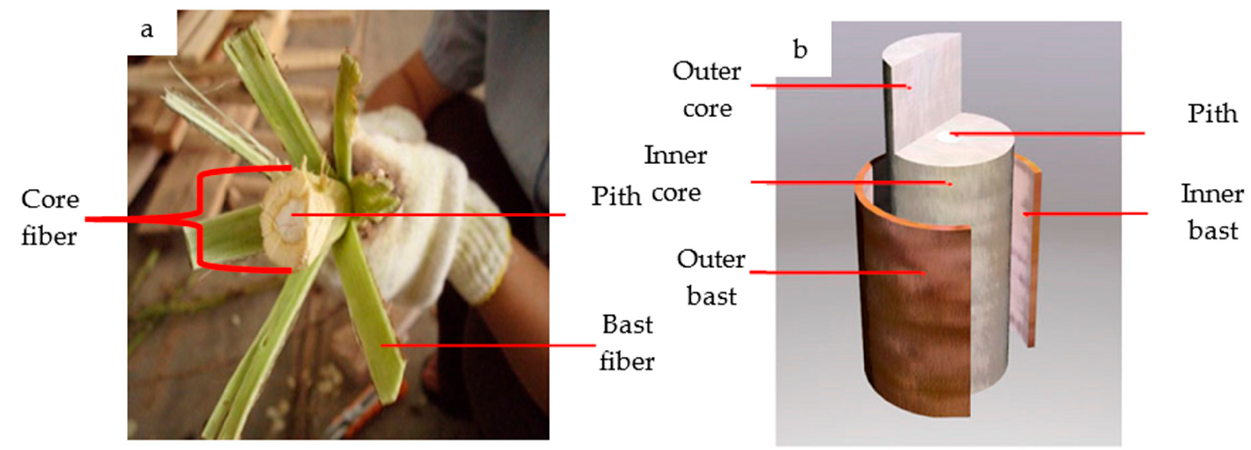
Figure 1. Kenaf outer and inner parts of the stem: ( a ) photograph, and ( b ) a sketch of the kenaf parts. Source: Figure reproduced with copyright permission from Juliana et al. (2012) [6]. Table 1. Comparison of the some of the properties between kenaf bast and core. Sources: [7–14].